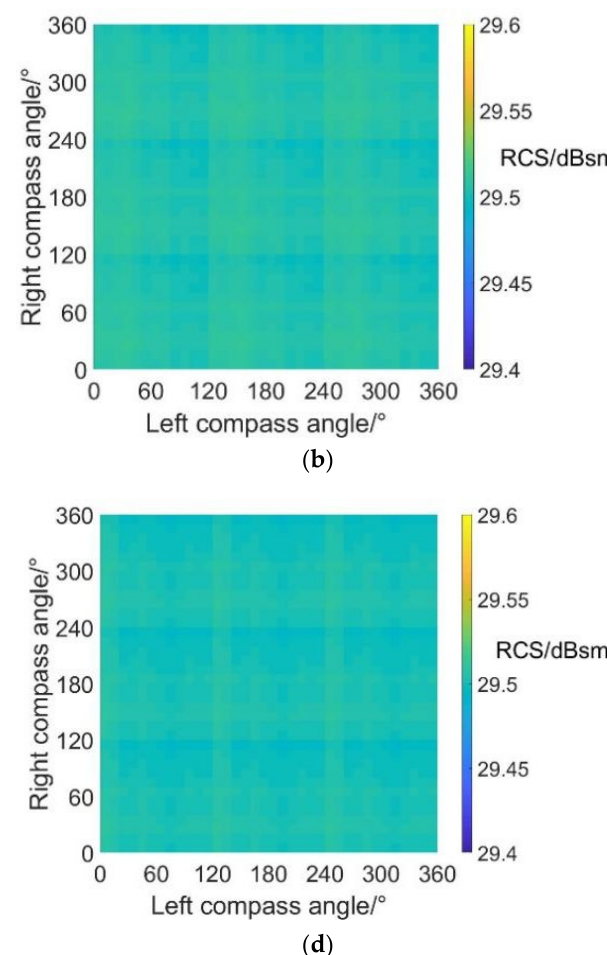
difference = 30 ◦ and 90 ◦ , the average RCS reaches 3 dBsm when compass angles satisfy